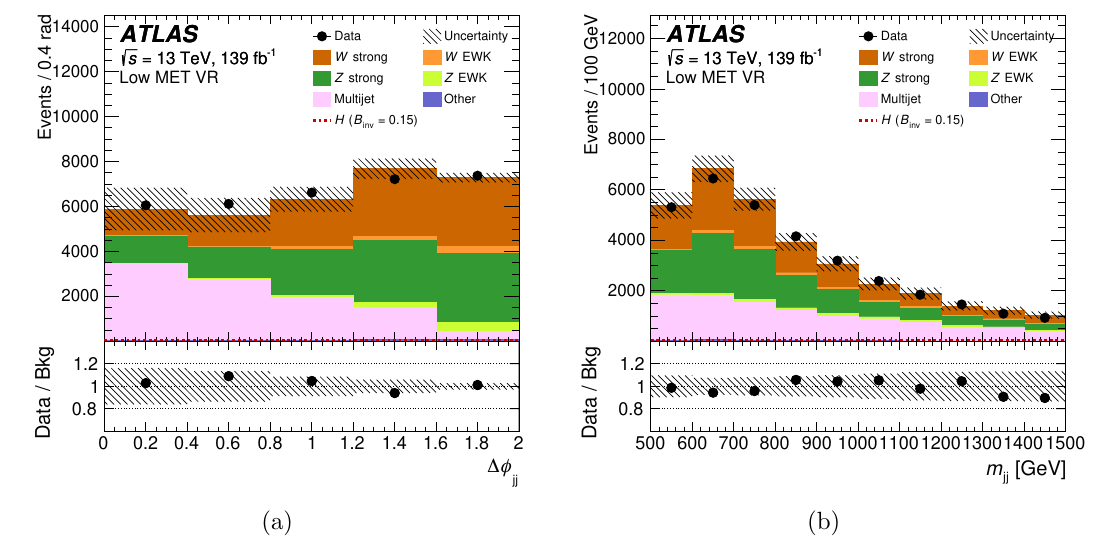
validation region. The T